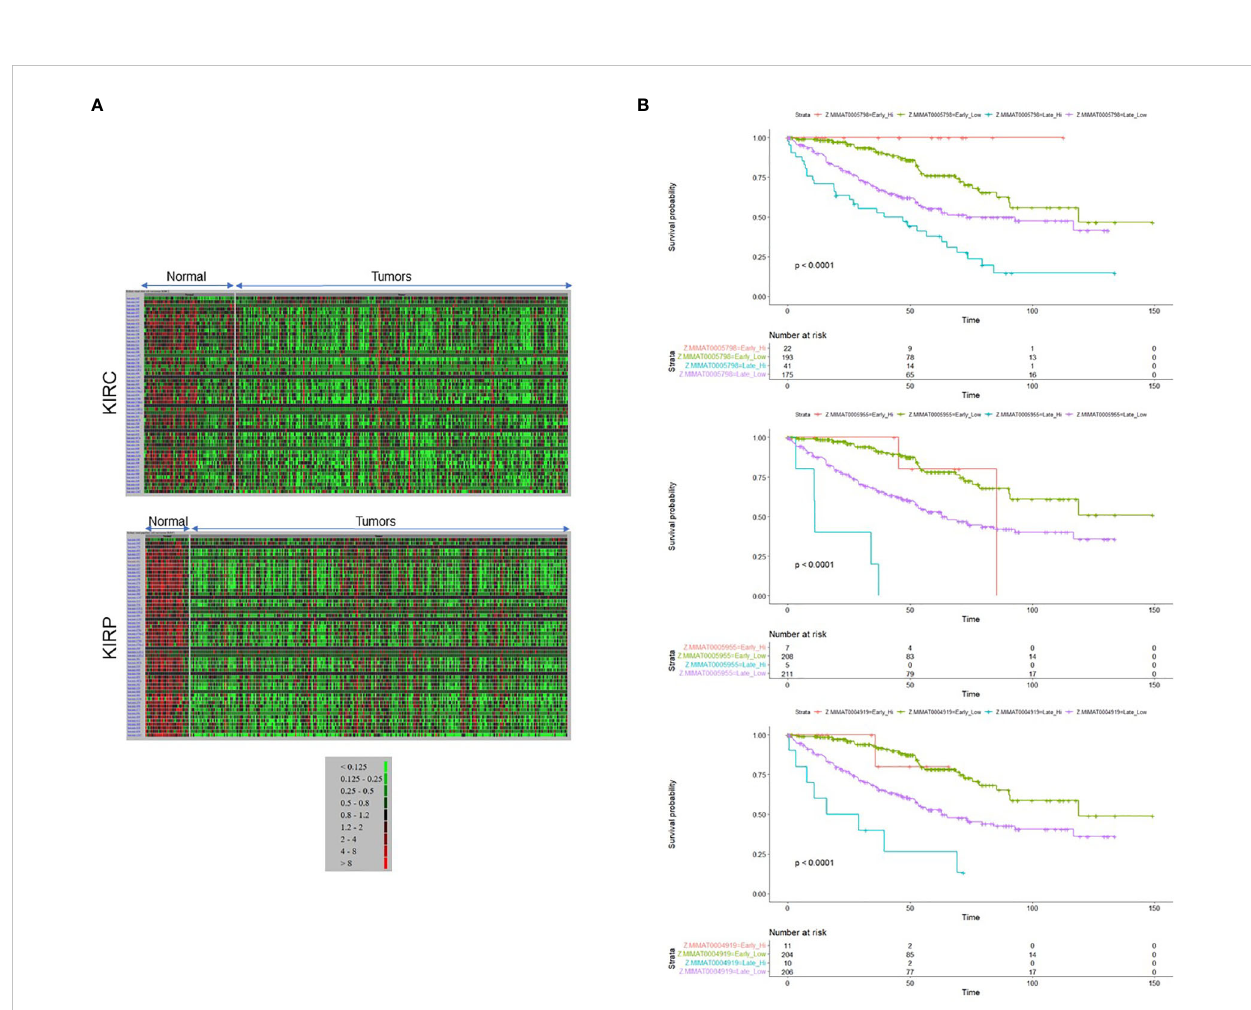
FIGURE 2 14q32 microRNA expression level corresponds to the disease aggressiveness. (A) Heat maps representing 14q32 miRNAs generated from TCGA patient data derived from (A) KIRC (top panel) and KIRP (bottom panel) data sets. (B) Patient survival outcomes for MIMAT0005798 (miR-1185-5p), MIMAT0005955 (miR-1197), MIMAT0004919 (miR-541-5p) are shown.